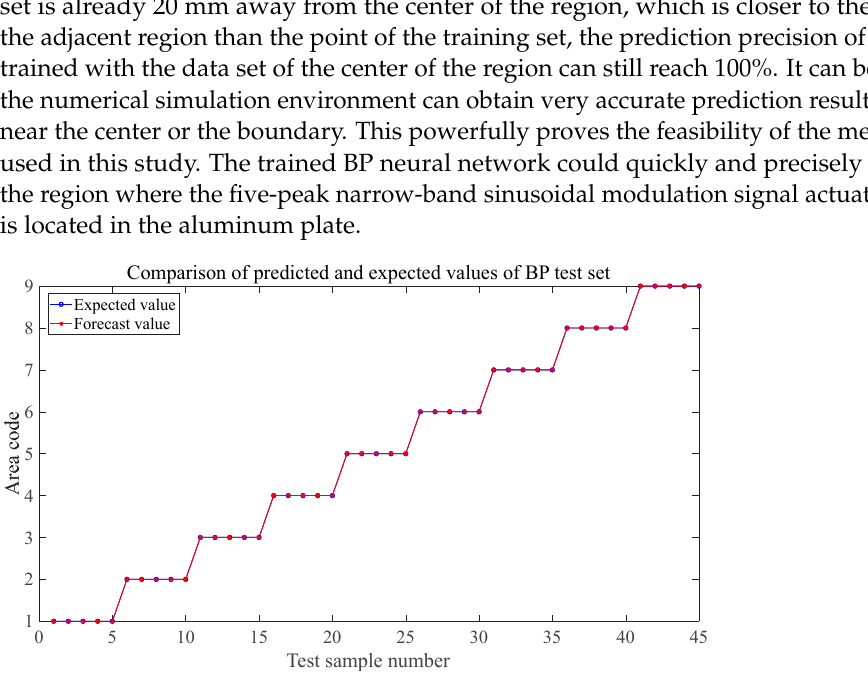
Figure 12. The test set excitation point is 20 mm away from the center.